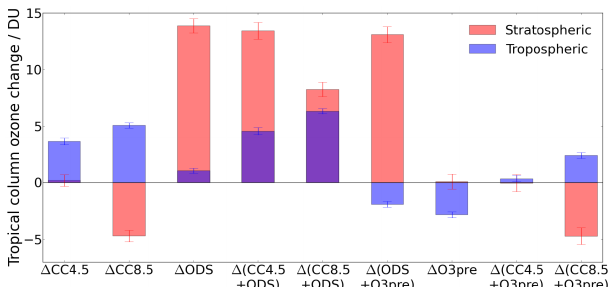
Figure 2. Changes in annual mean, area-weighted tropical (30 ◦ S– 30 ◦ N) stratospheric (red) and tropospheric (blue) column ozone for the single- and combined-forcing experiments relative to Base. Par- tial columns are calculated assuming a thermal tropopause and a 50km stratopause. Error bars indicate the 5–95% confidence inter- val, calculated as ± 1.96 times the standard error in the mean of the